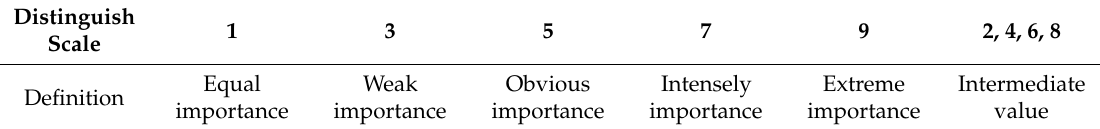
Table 1. The scale and definition of the assessment